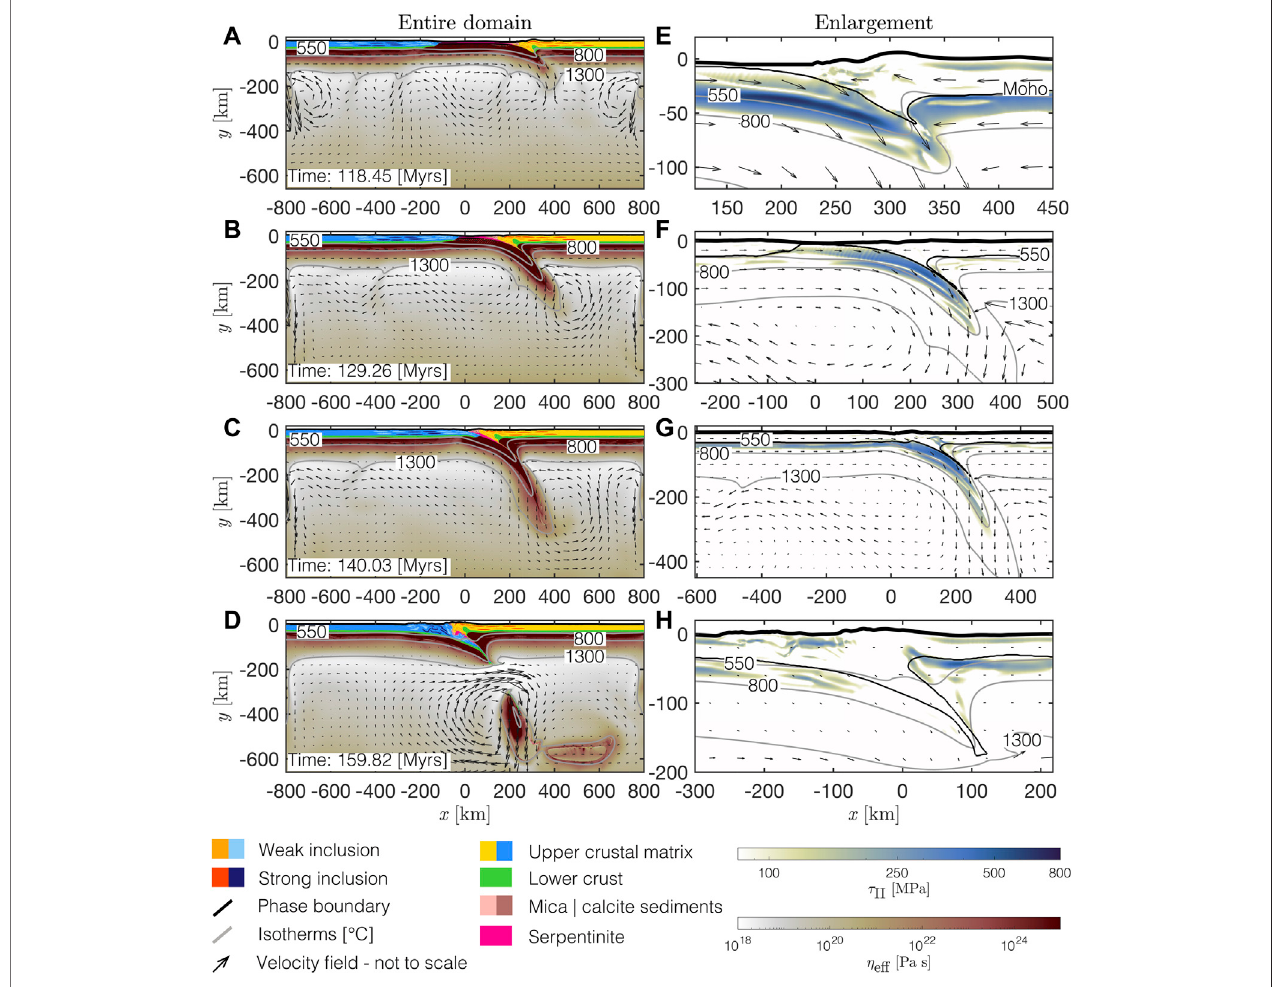
FIGURE 3 | Geodynamic evolution of the reference model NOSLIM (no additional applied stress limit). (A – D) : Entire domain. White to red is the effective viscosity calculated by the numerical algorithm. Colouring of lithologies as indicated in the legend. (E – H) : White to blue is the second invariant of the deviatoric stress tensor as calculated by the numerical algorithm. Glyphs in all panels show the velocity fi eld and grey solid lines are several isotherms predicted by the numerical algorithm.